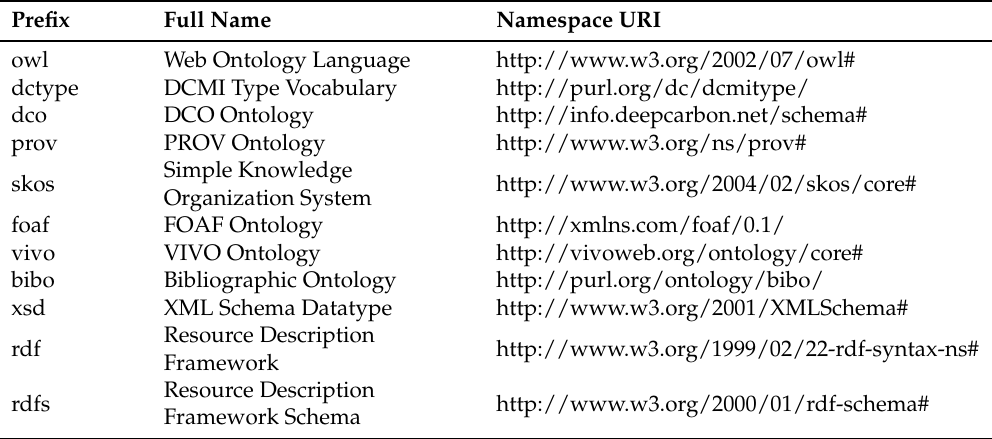
Table 1. Ontologies and schemas reused in the model for data type